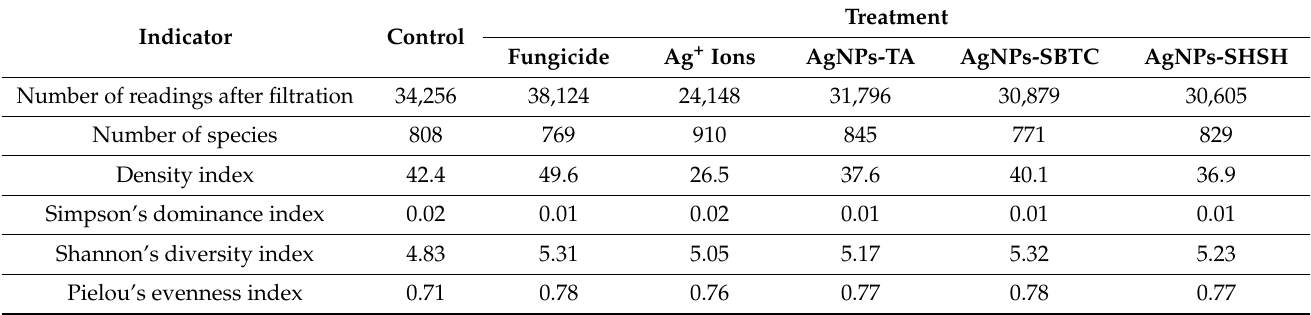
Table 2. Community indices for bacterial operational taxonomic units in the control and treated